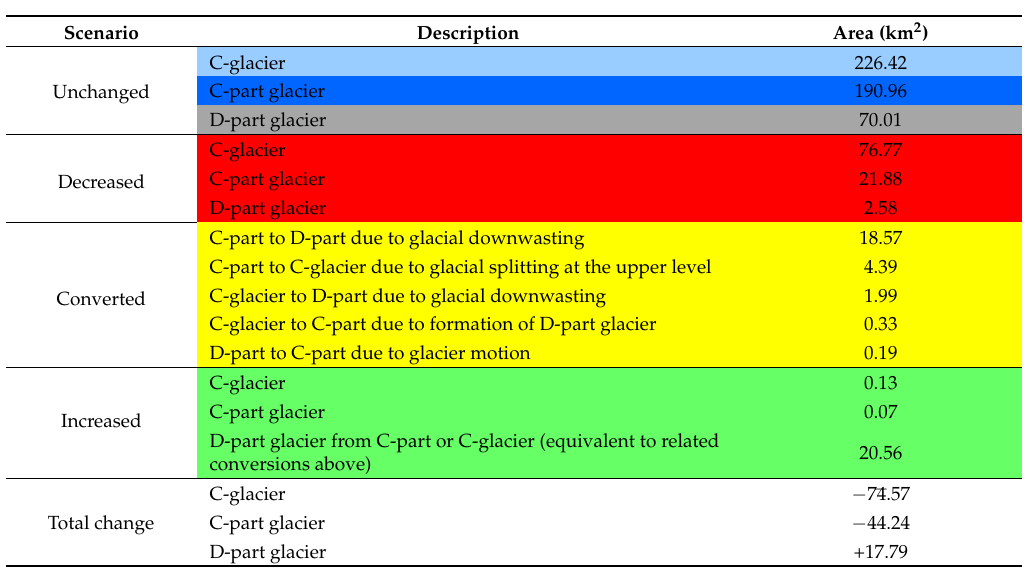
Table 4. Summary of various scenarios of glacier changes between 1988 and